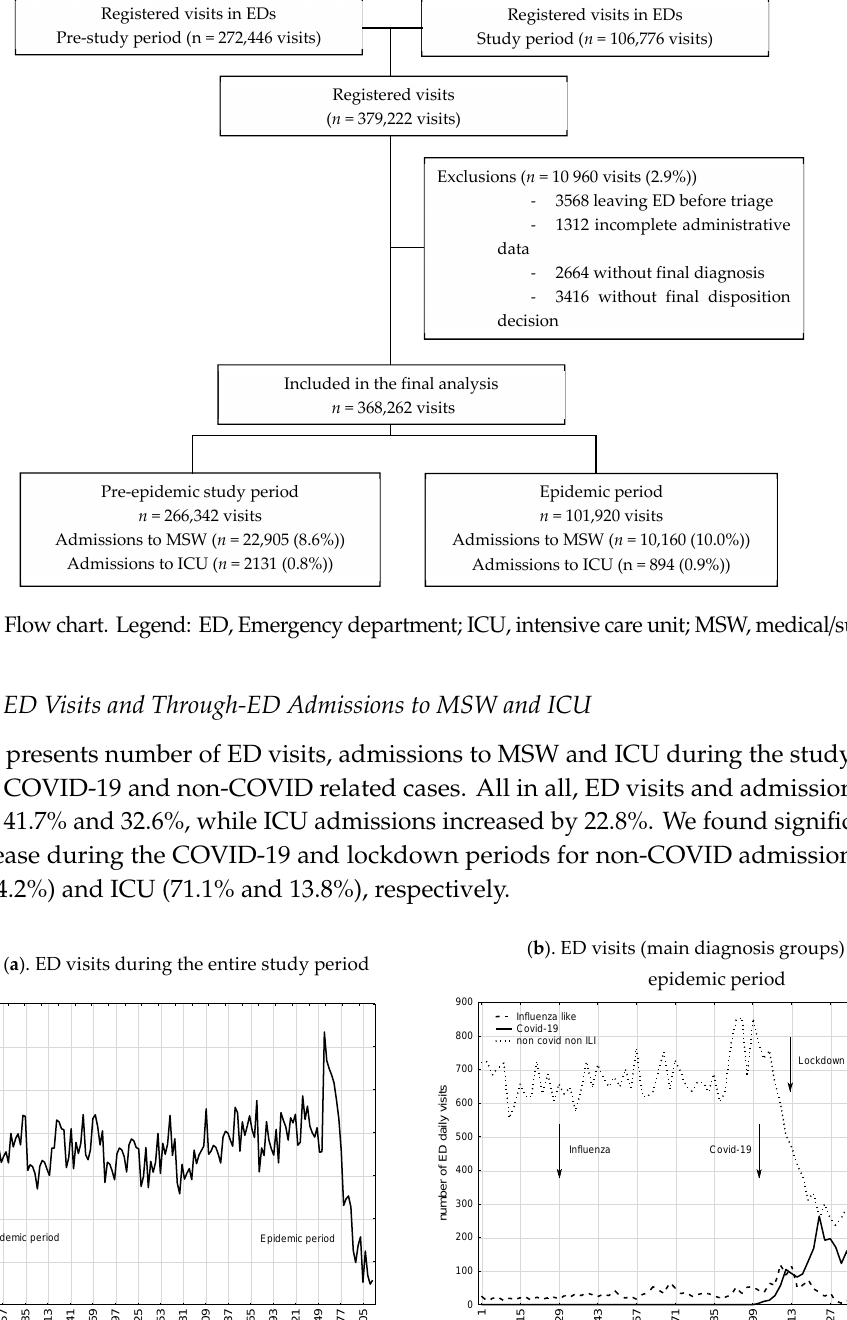
Figure 2. ( a ) ED visits during the entire study period, from 25 November 2018 to 25 November 2019 (pre- epidemic period) and from 26 November 2019 to 26 March 2020 (study period including influenza- and COVID-19-epidemic and lockdown periods); ( b ) ED visits subgroups during Influenza, Covid-19, and lockdown periods (from 26 November 2019 to 26 March 2020); ( c ) MSW admissions during epidemic period (from 26 November 2019 to 26 March 2020); ( d ) ICU admissions during epidemic period(from 26 November 2019 to 26 March 2020). Caption: Admissions are given as a function of